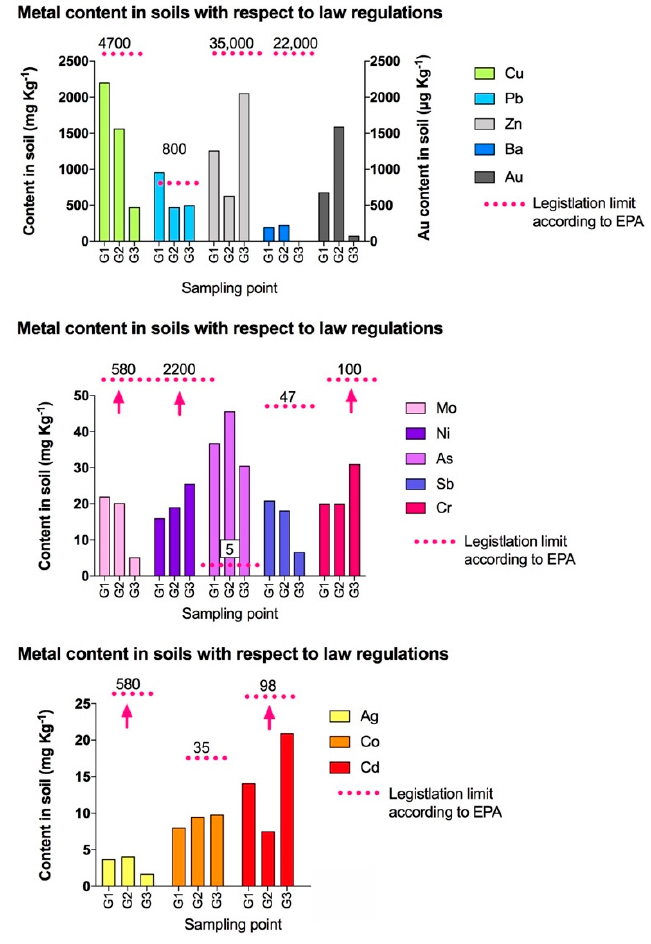
Figure 8. Metal concentrations in analyzed soil samples (G1–G3) collected in August 2018 in the vicinity of Olmaliq city. Dotted lines indicate the legislation limit (EPA) of elements in soils at industrial sites.